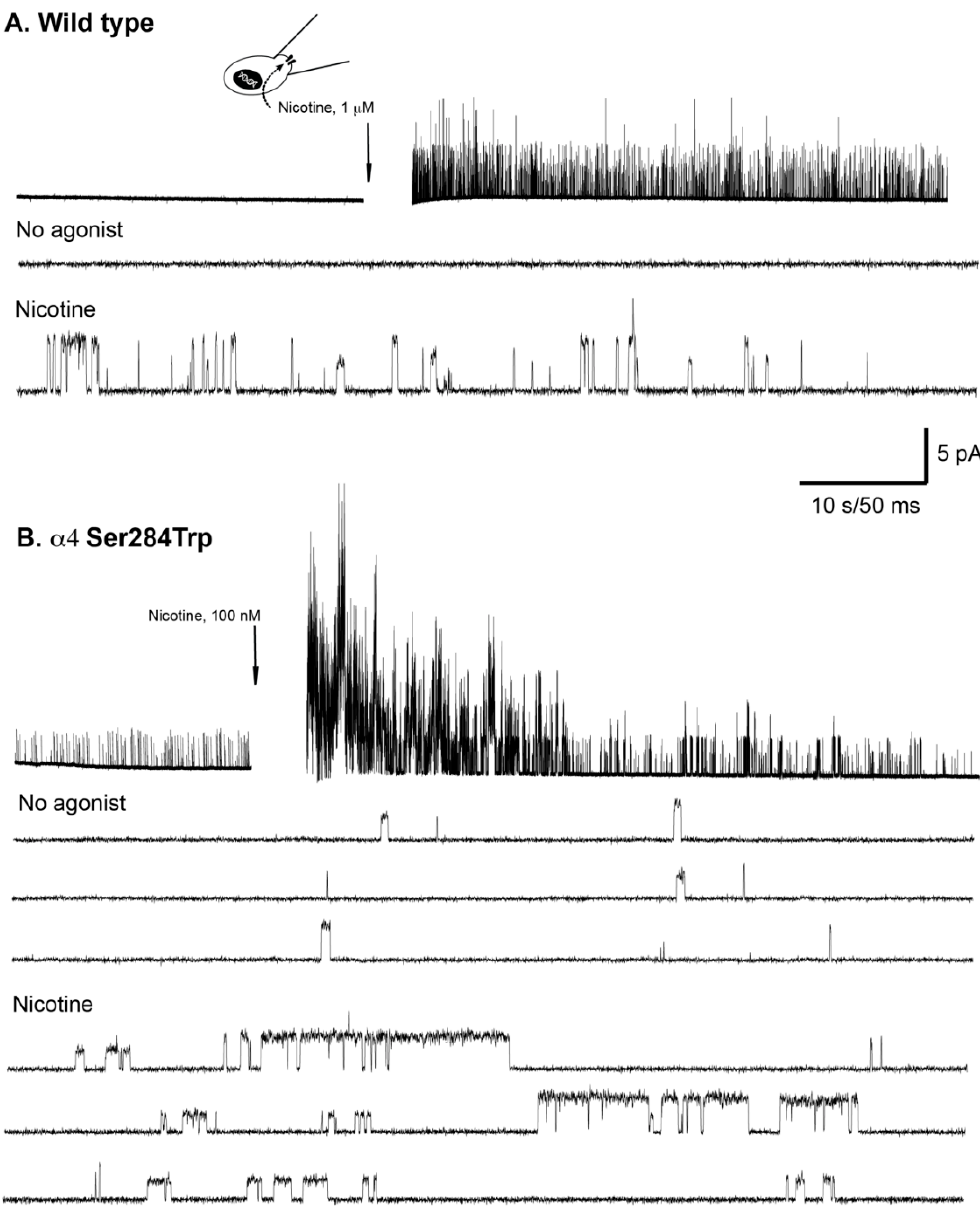
Figure 4. Single channel recordings from wild type and α 4-Ser284Trp nAChRs before and after addition of nicotine. ( A ) Recording from a Bosc-23 cell expressing wild type α 4 β 2 nAChRs. Upper trace shows current recorded from the same patch of membrane before and after addition of 1 µM nicotine to the extracellular solution (1 kHz Gaussian filter). Noise artifact during addition of nicotine is removed (gap). Lower traces show segments of the upper trace with increased time resolution (3 kHz Gaussian filter). ( B ) Recording from a Bosc-23 cell expressing α 4Ser284Trp β 2 nAChRs. Upper trace shows current recorded from the same patch of membrane before and after addition of 100 nM nicotine to the extracellular solution (1 kHz Gaussian filter). Lower traces show segments of the upper trace with increased time resolution (3 kHz Gaussian filter). The recordings in A and B were obtained in the cell-attached patch configuration at a membrane potential of − 70 mV.